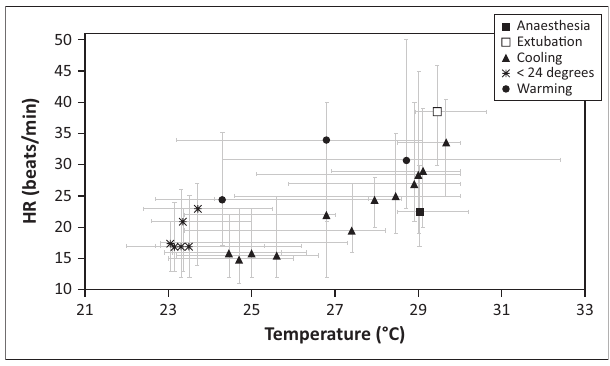
Data (median ± range) are shown for conditions of anaesthesia, extubation, cooling (< 12 hours of recovery), under 24 °C (hours 13–18 of recovery) and warming (hours 19–21 of recovery). FIGURE 2: Plot of the relationship between heart rate (beats per min) and internal body temperature (°C) for crocodiles 1, 2, 4 and 5 from their anaesthesia through recovery, showing evidence of heart rate hysteresis dependent on cooling or warming state, and separation of anaesthesia and extubation conditions from the trend for